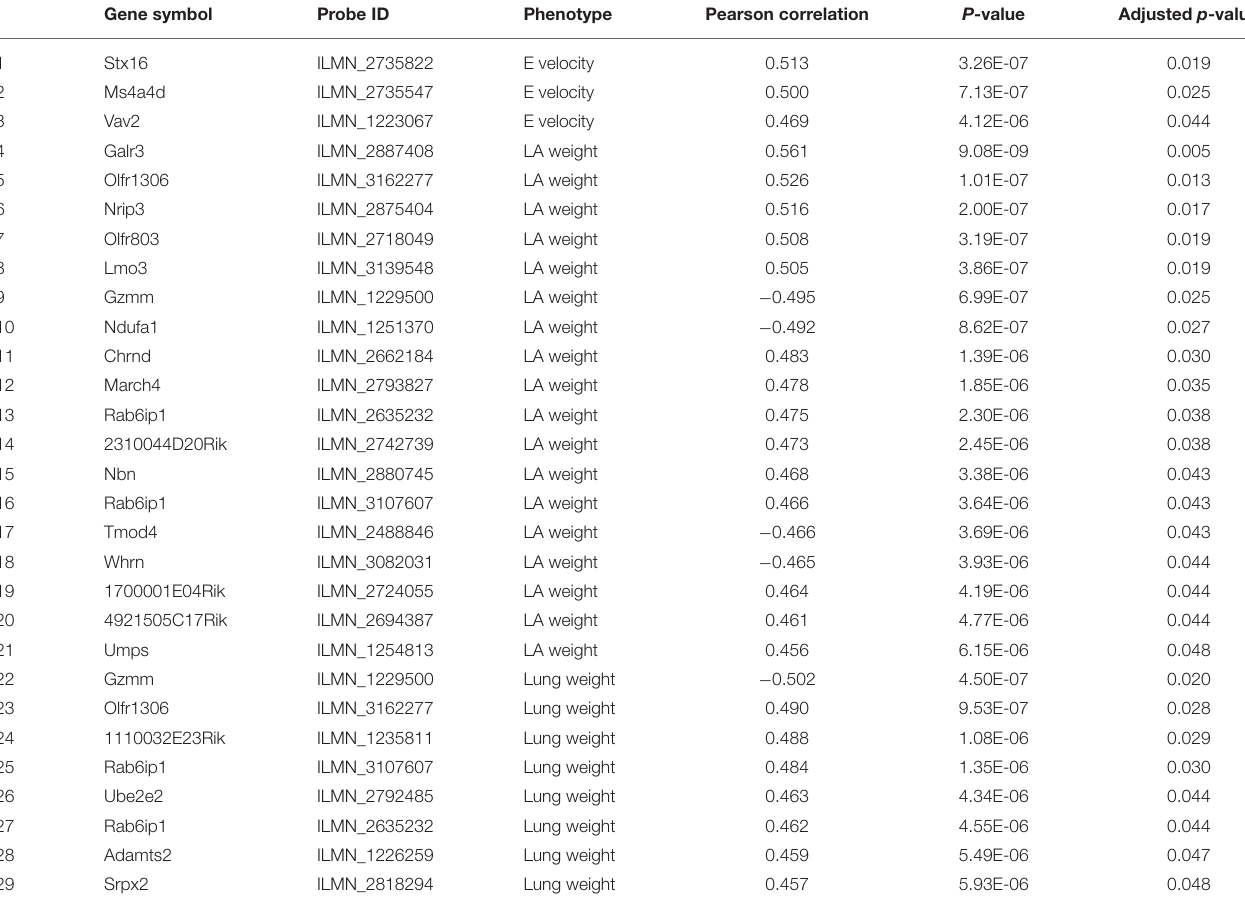
TABLE 1 | Significantly correlated isoproterenol-induced transcripts with diastolic function parameters including left atrial weight, lung, E and A velocity and E/A ratio. Gene